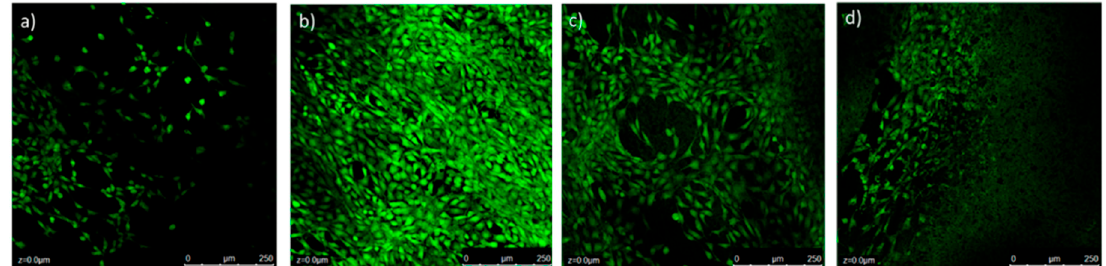
Figure 12. 96 h cell culture results of NIH3T3 cells on 3D printed TPU/PLA with different GO loadings: ( a ) 0 wt % GO, ( b ) 0.5 wt % GO, ( c ) 2 wt % GO, ( d ) 5 wt % GO. Green color indicates live cells, whereas red color indicates dead cells. Adapted from [198], with permission from American Chemical Society, 2017.